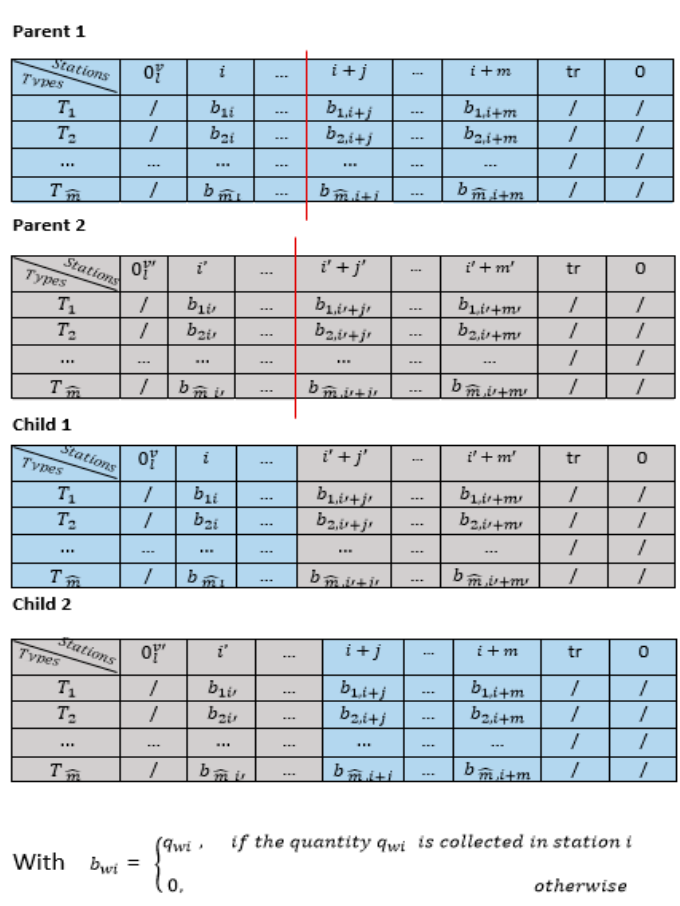
Figure 9. Example of the first phase in the crossover procedure.